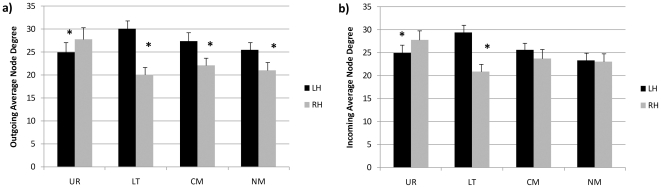
Average node degree for each condition and hemisphere.Left panel (a) shows the outgoing node degree. Right panel (b) shows the incoming node degree. Black bars: left hemisphere, grey bars: right hemisphere.